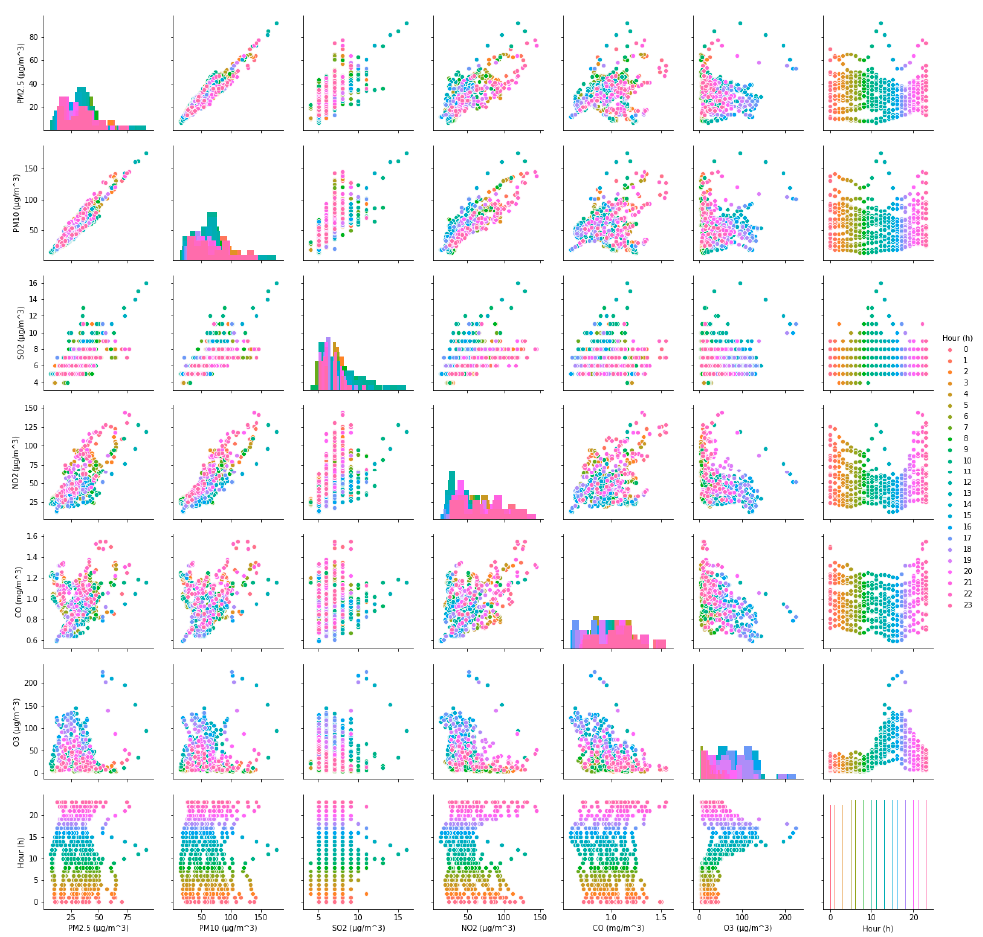
Figure 5. The pollutant concentrations distribution in case one.